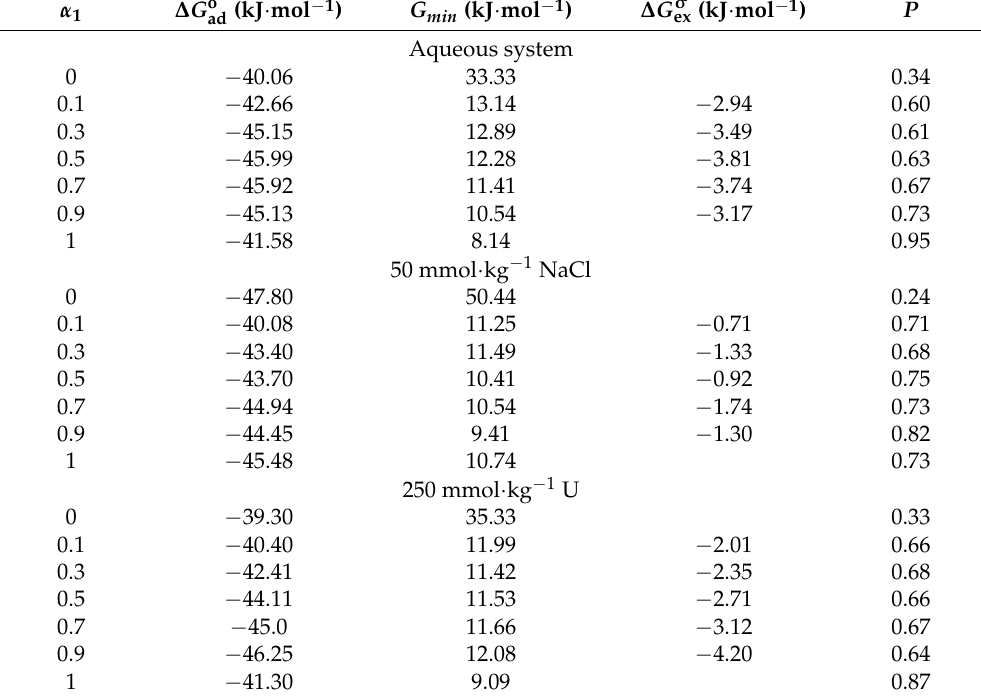
Table 2. Various thermodynamic parameters along with packing parameter ( P ) for pure and IMP+TX- 100 mixture in various